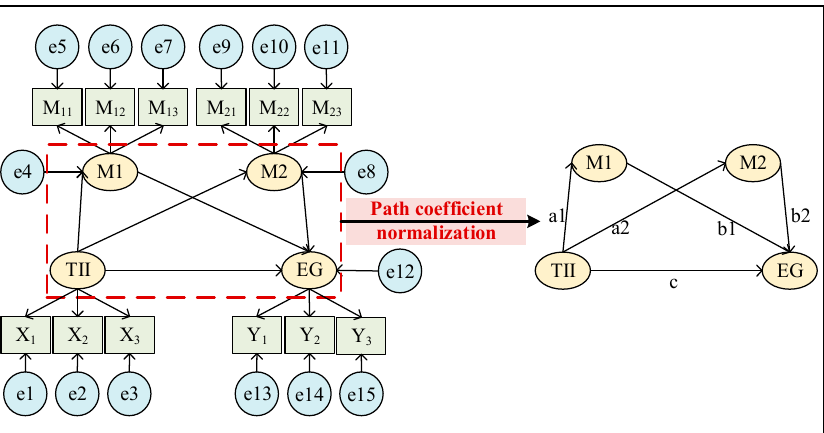
Figure 4. The conceptual model of mediating effects.